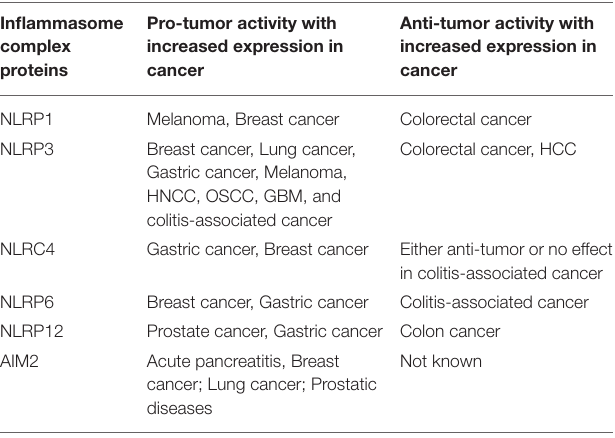
TABLE 1 | Pro-tumor and anti-tumor activity of inflammasomes in various cancer types. Inflammasome